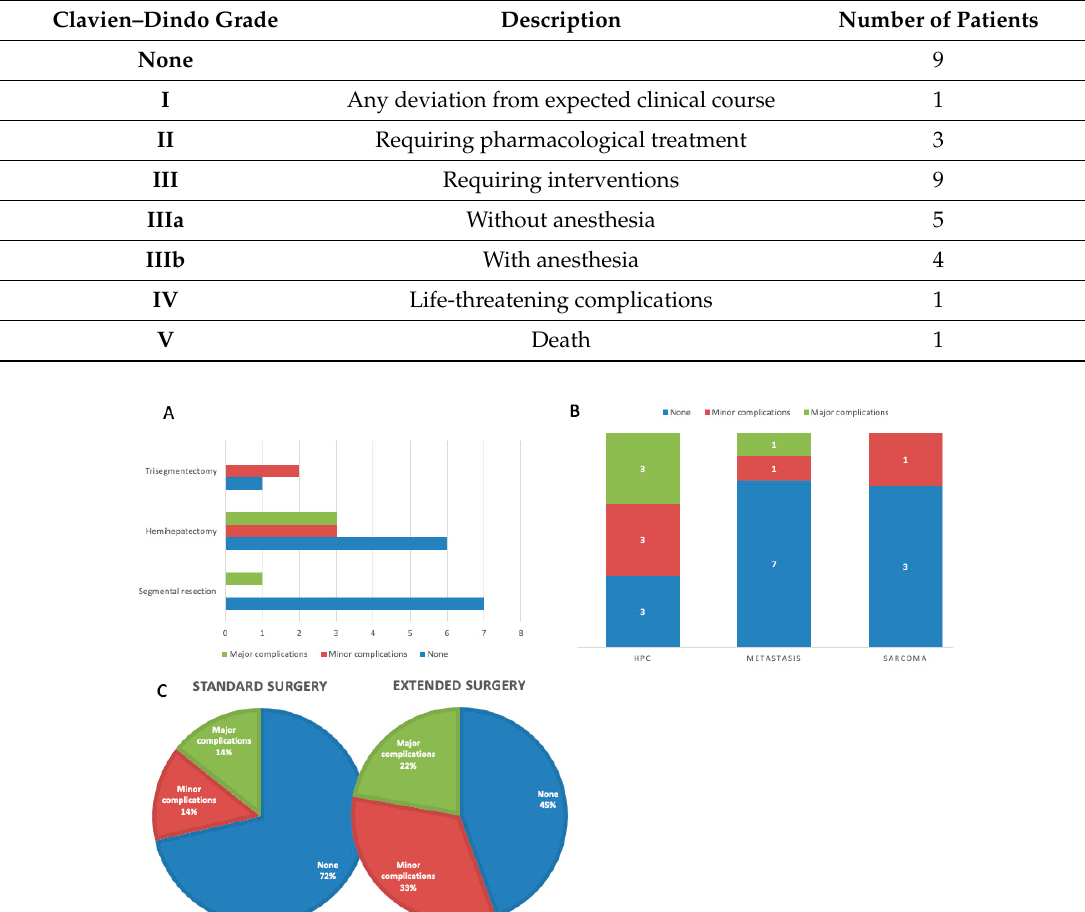
Table 2. Number of patients experiencing postoperative complications according to Clavien–Dindo grades.